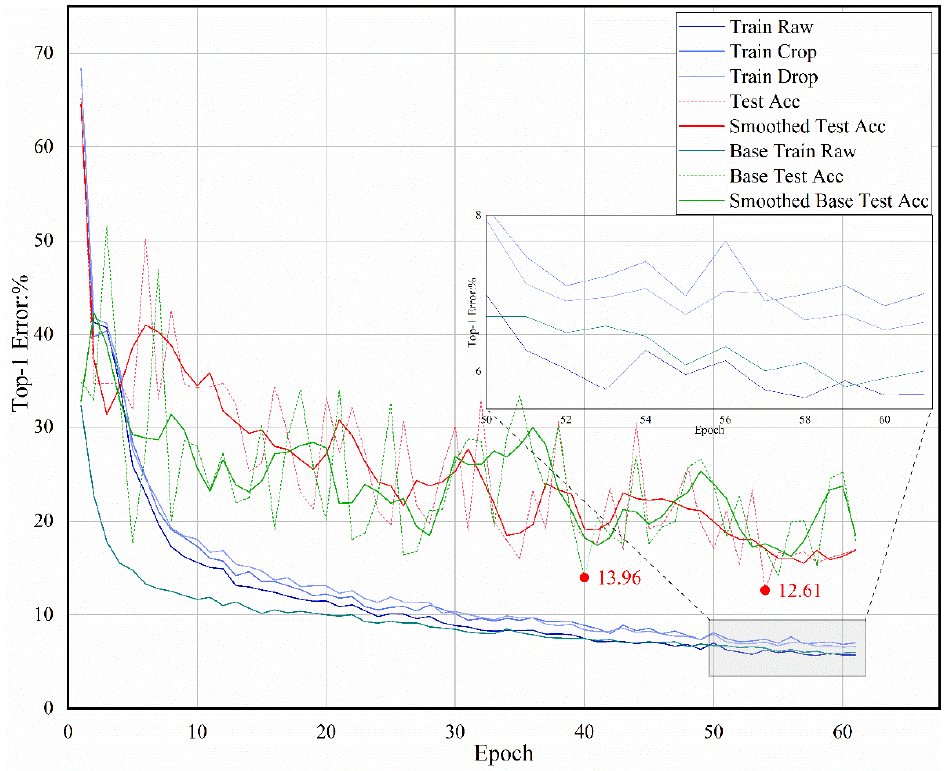
Figure 7. Training curves of our method and the baseline on C-NMC. Dashed lines denote the testing error. Our method performs better than the baseline.